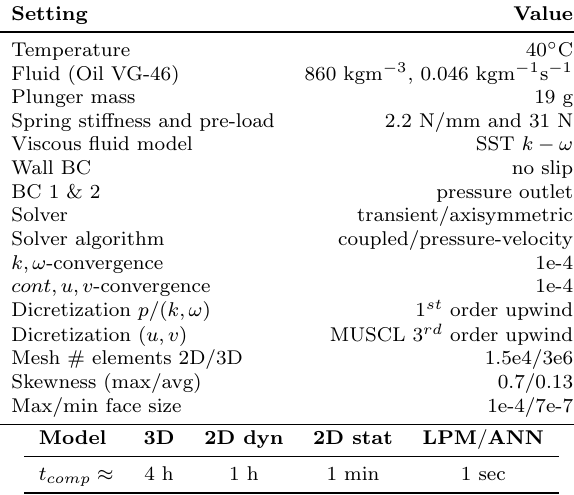
Table 1: Summarized setting and applied values for the static CFD analyses, certain mesh metrics are given as approximate